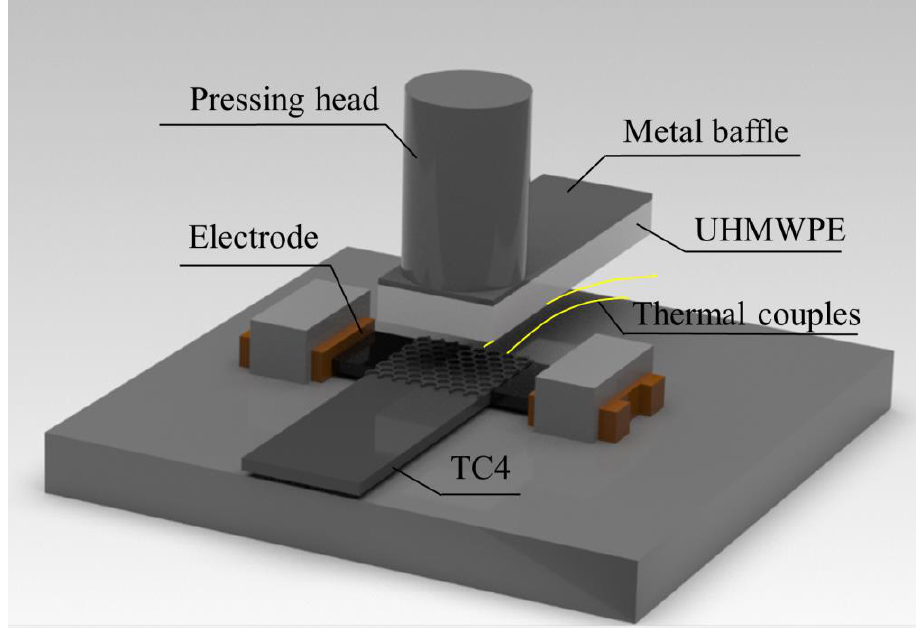
Figure 2. A 3D schematic of the hot pressing joining system.